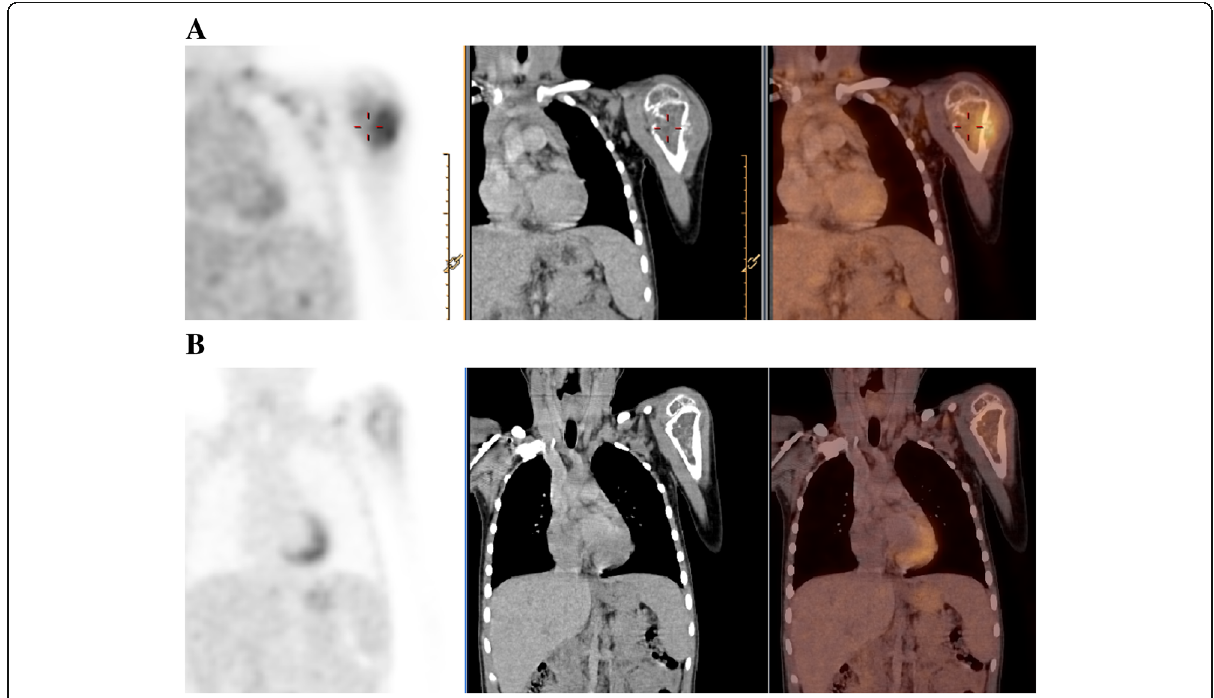
Fig. 1 A 17-year-old male patient with left humeral Ewing sarcoma. a Coronal PET (left), coronal CT (middle) and coronal fused PET/CT PET (right) images for staging revealed pathological uptake (SUV = 3.9) at the primary tumor site matching with pathological results. b Follow-up scans after chemotherapy revealed regression in SUV uptake (2.3). This patient underwent limb salvage surgery and pathological assessment revealed 95% tumor necrosis (good responder)